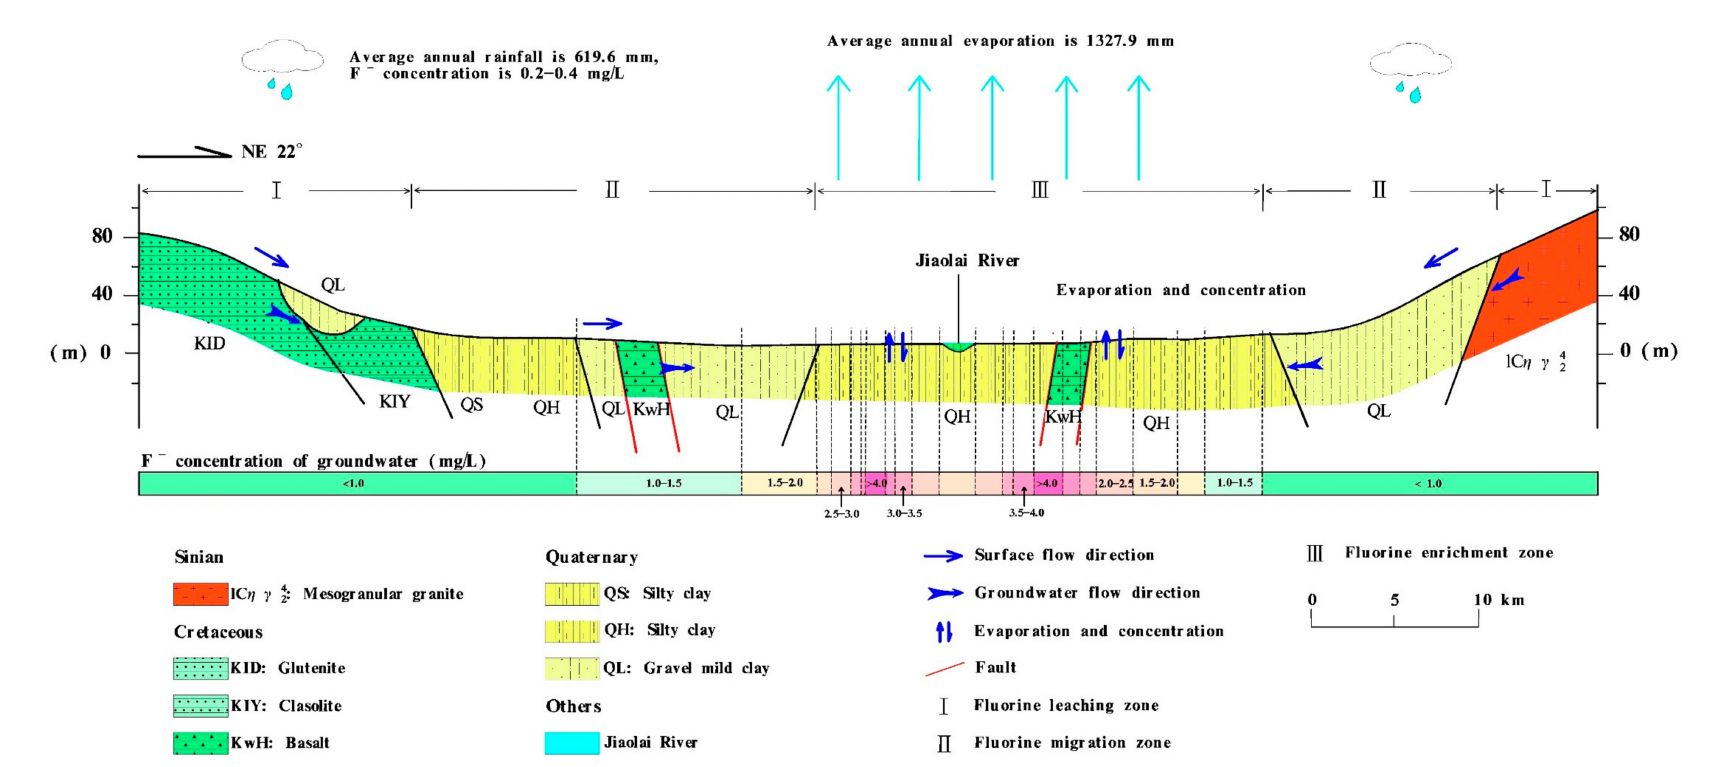
Figure 8. Model explaining the formation of shallow high-fluoride groundwater in the Jiaolai Basin, Jiaodong Peninsula, eastern